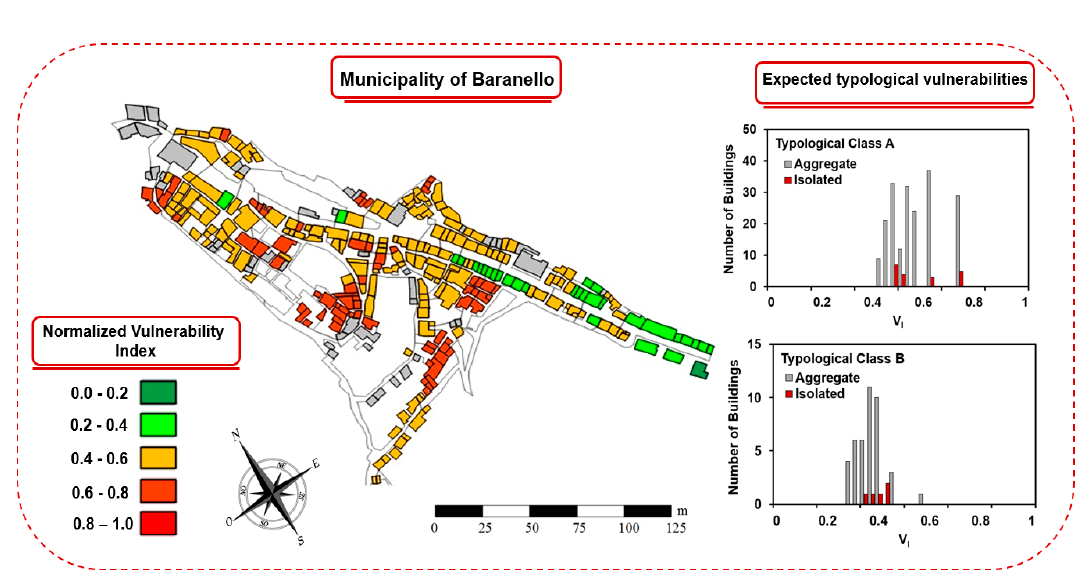
Figure 11. Vulnerability distribution in the municipality of Baranello.